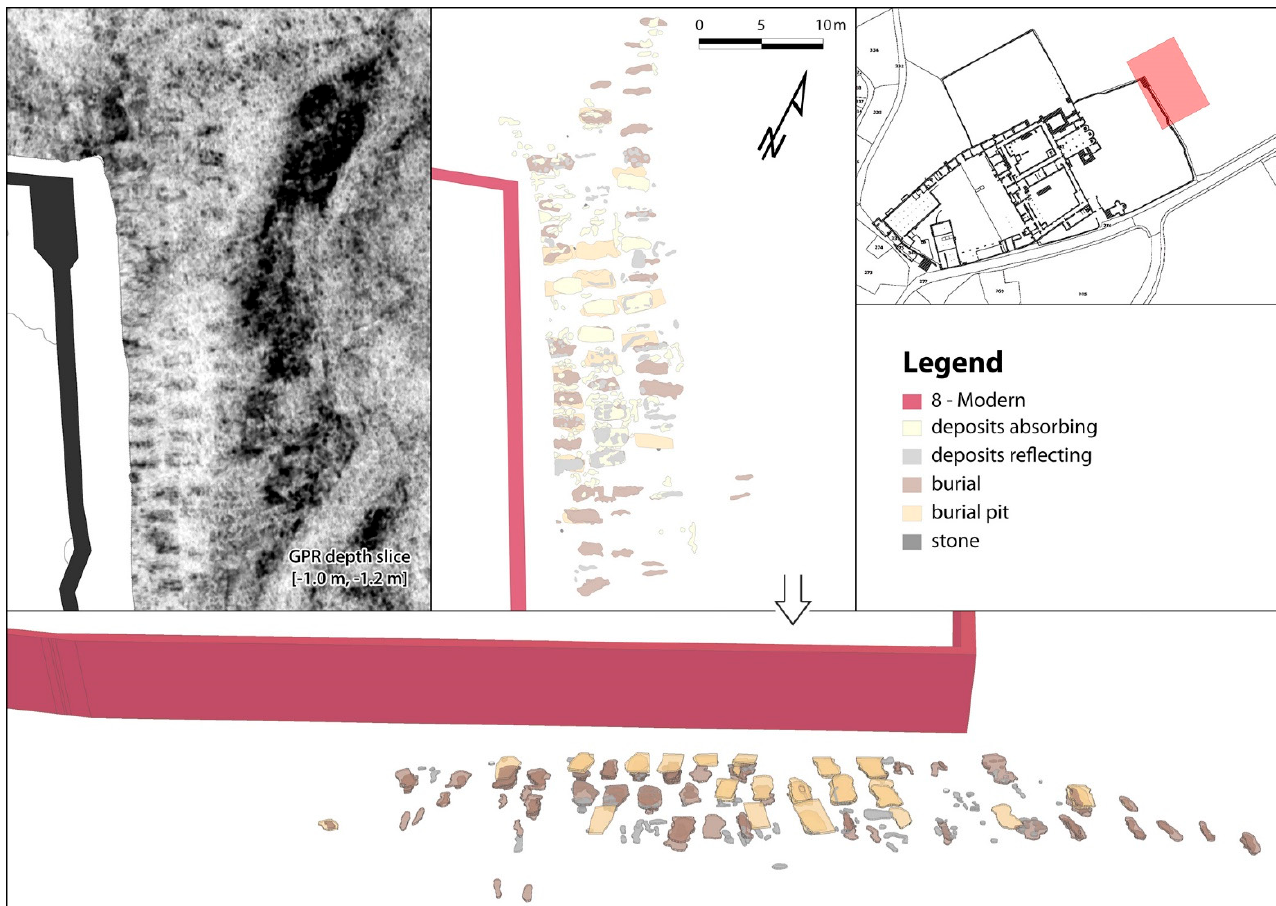
Figure 10. Detailed 2D (upper row) and 3D view (lower row) on the row graves in the northwestern corner outside the modern graveyard. All other mapped archaeological features have been removed for clarity.